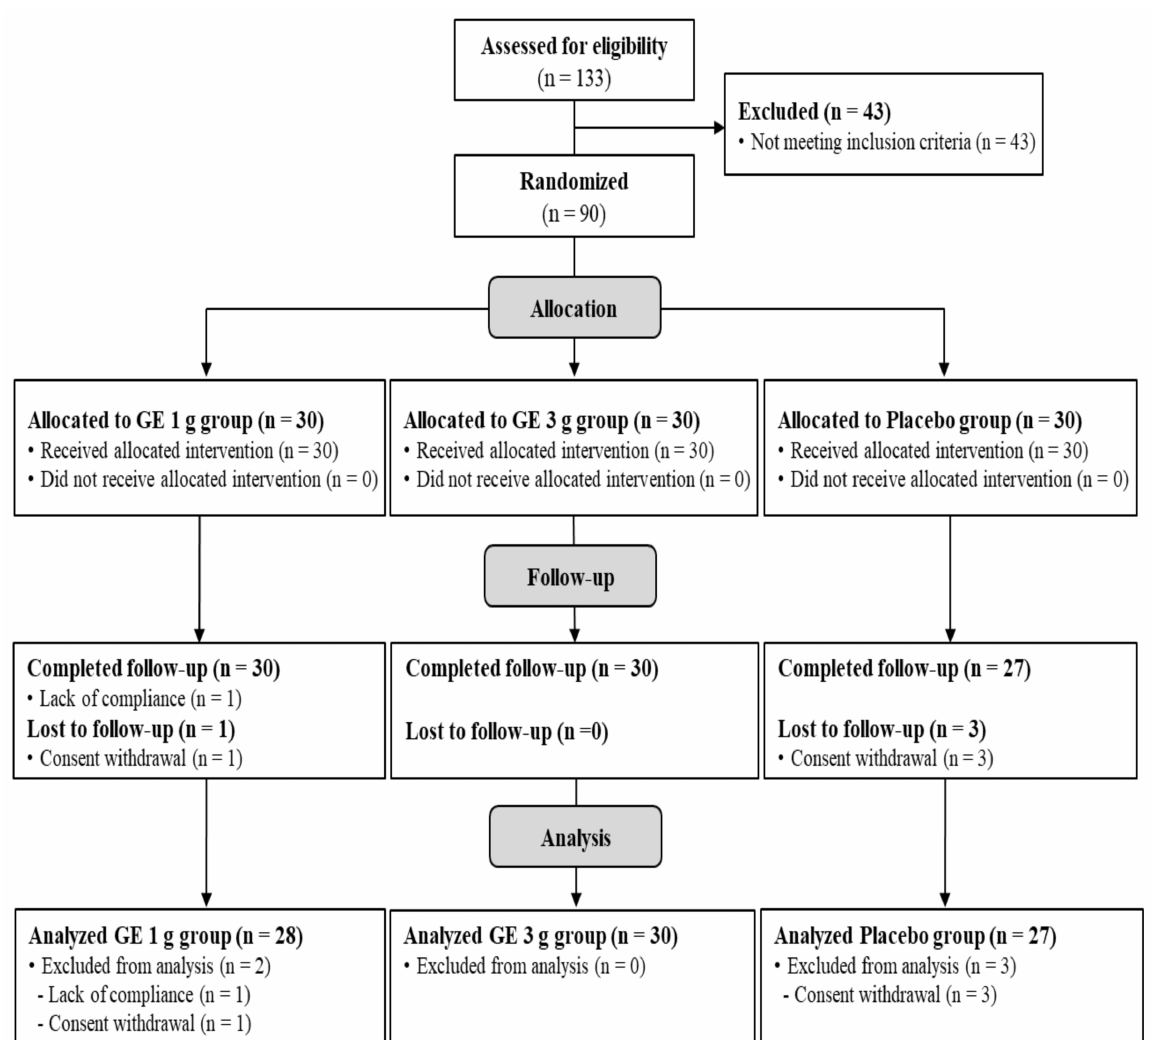
Figure 2. Flow diagram showing the subject recruitment process in the